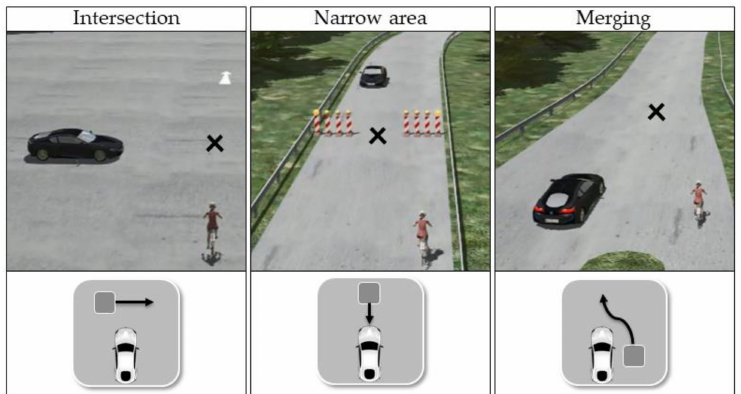
Figure 3. Implementation of the three derived situations in a driving simulation with a cyclist as the interaction partner. The arrows indicate the trajectories of the automated vehicle and the cyclist, and the black cross represents their virtual crossing point.